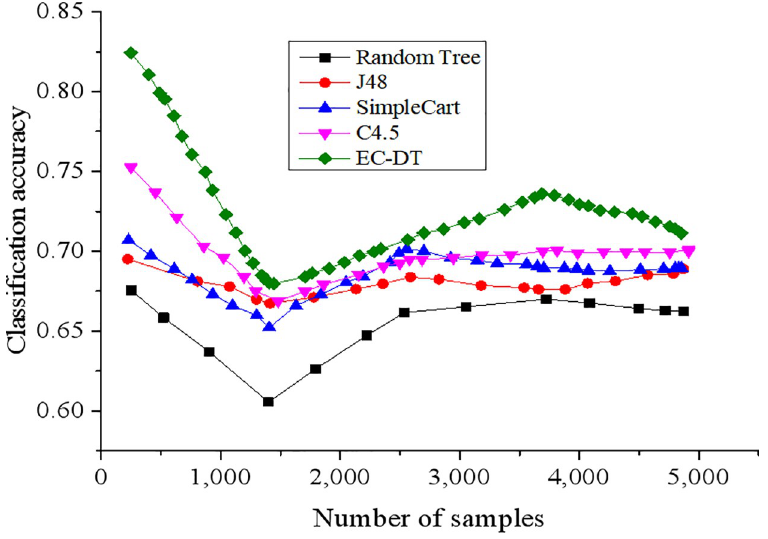
Fig 3. Comparison results of single decision tree algorithms and